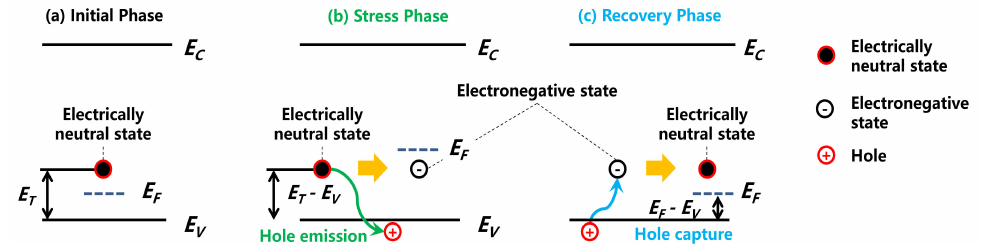
Figure 3. Schematic of acceptor-trap-induced capture and emission of free carriers.